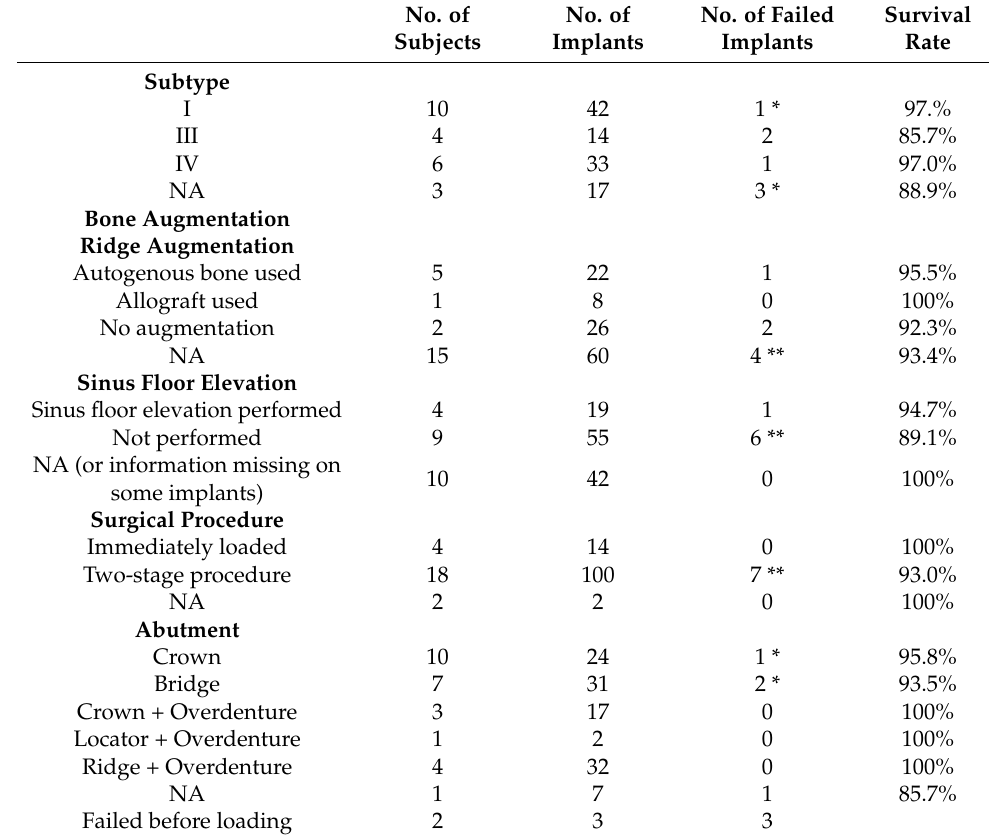
Table 7. Implant survival rates in different treatment procedures and biological